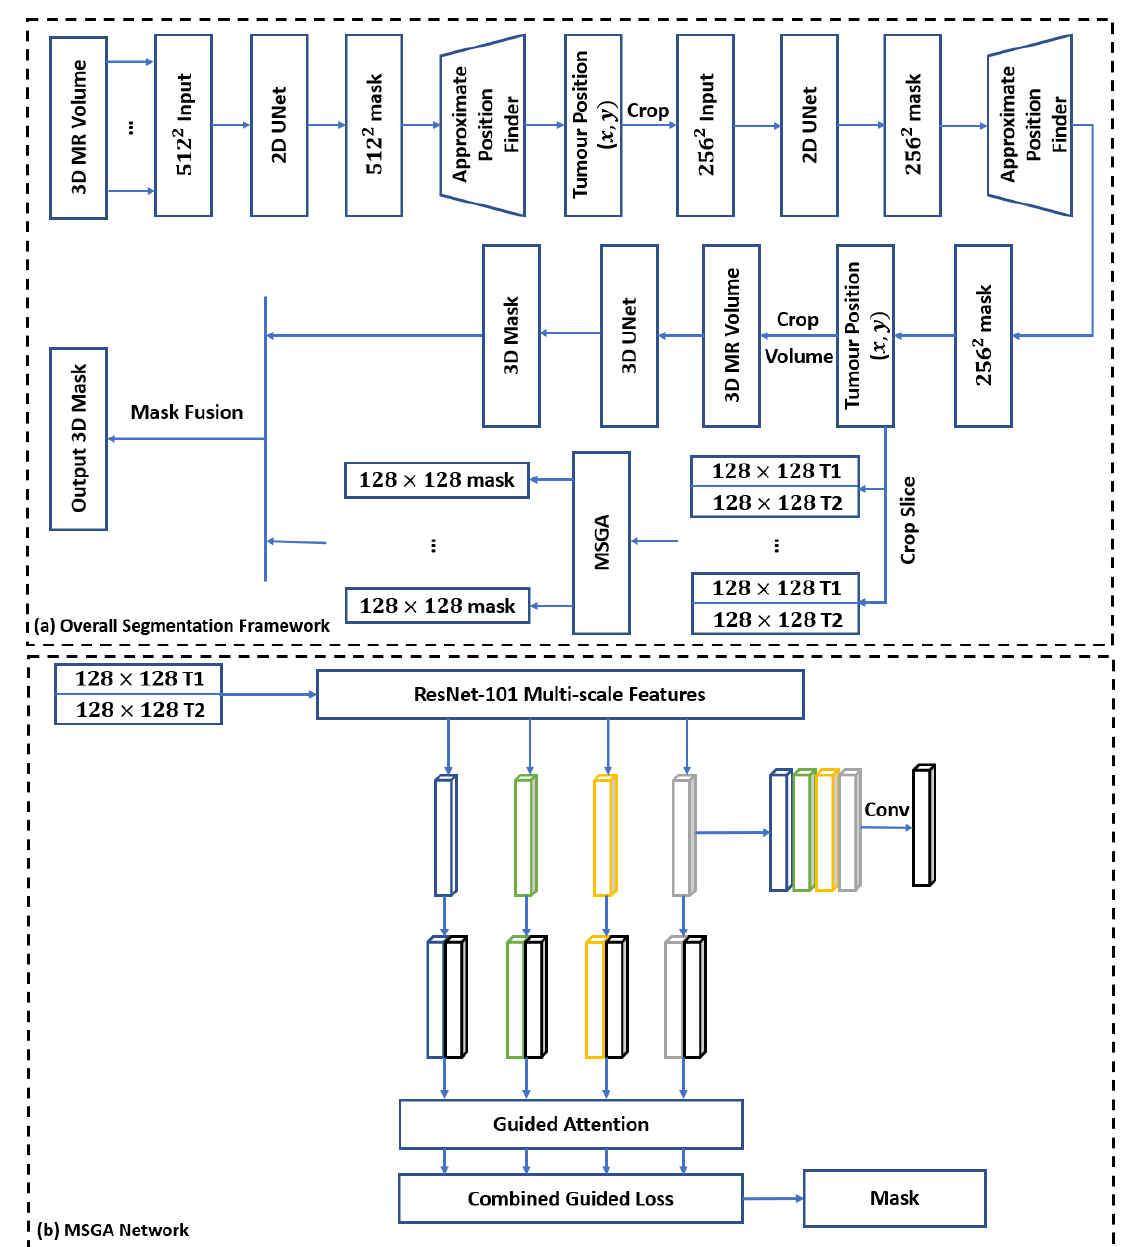
Figure 2. ( a ) Segmentation framework overview. For a volumetric input image (contrast-enhanced T1-weighted, 512 × 512 × 128 voxels), first, all slices are fed to a 2D UNet one by one. The generated masks from the 2D UNet are used to find an approximate tumour position ( x , y ) . The volumetric input image is then cropped around ( x , y ) into a 256 × 256 × 128 voxel volume. A similar procedure is performed to reduce the size of the volumetric image containing the tumour to 128 × 128 × 128 voxels. This volume is then fed into a 3D UNet for segmentation with no patching. The slices of this volume are also fed to MSGA, after concatenation with the coregistered T2-FLAIR image, and the segmentation masks of MSGA are then fused with those of 3D UNet. ( b ) The MSGA network structure. Features extracted at different scales (shown in blue, green, orange, and gray) from ResNet-101 are concatenated and convolved (shown in back) and then self-concatenated and fed into the guided attention module. The resulting self-guided features are fed into the guided loss.